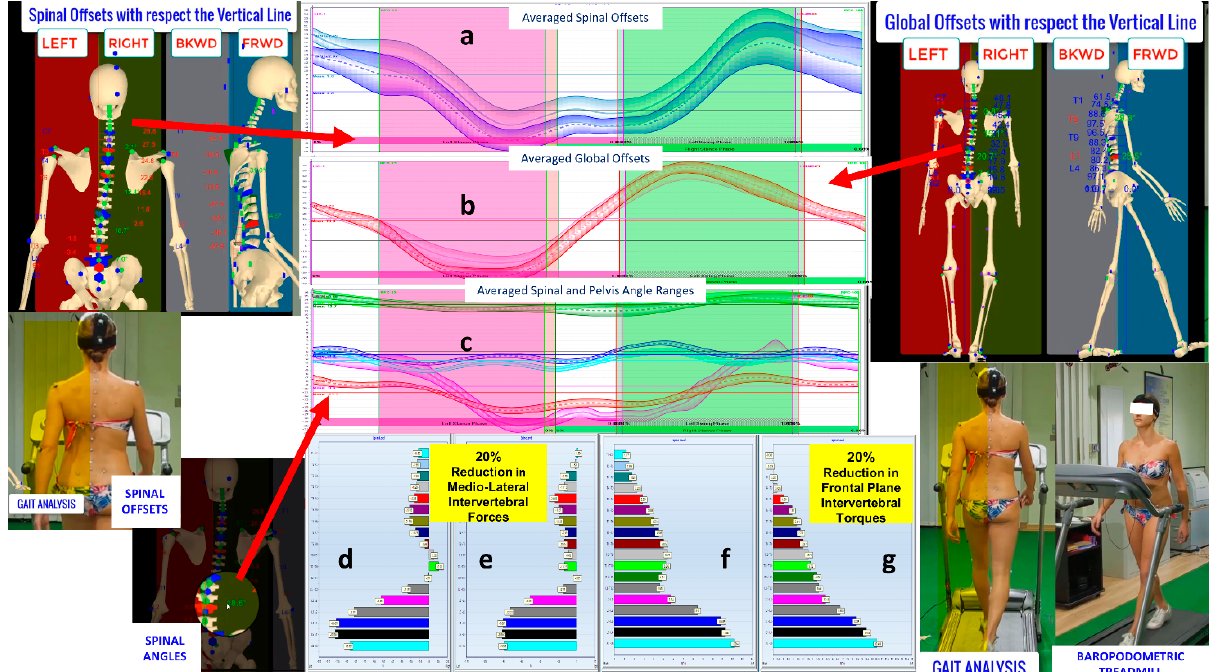
Figure 12. Mean gait cycle: baropodometric analysis (see text for explanation).